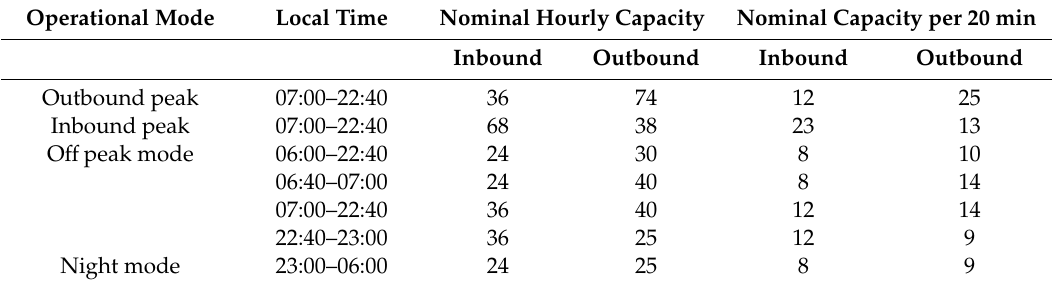
Table 1. Declared capacities at Schiphol Airport. Source: